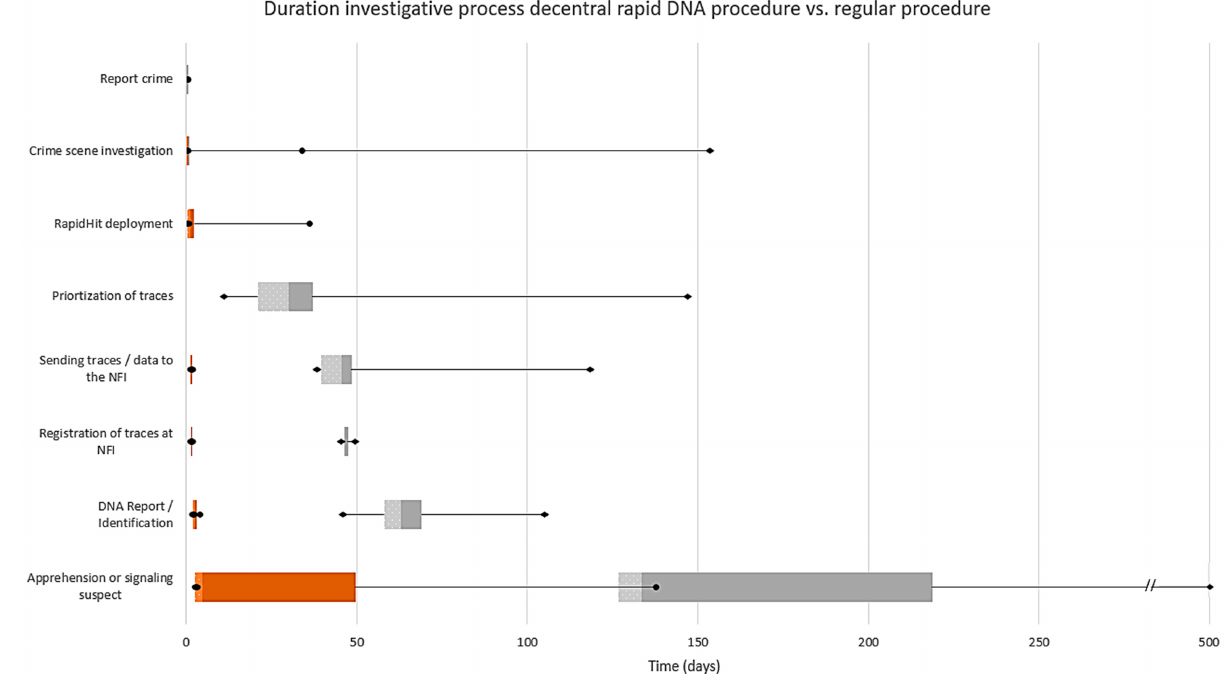
Figure 2. Horizontal box plots with the medians and quartiles categorized by the di ff erent stages of the investigative process over time (days). The orange plots show the decentral rapid DNA procedure. The grey plots show the regular DNA procedure.